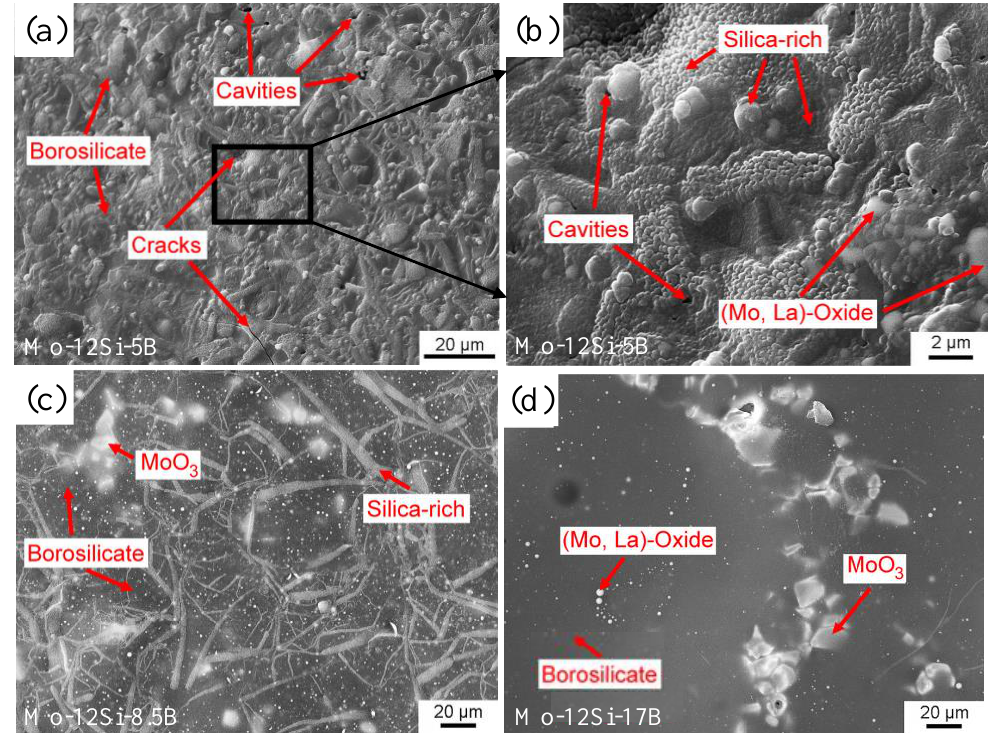
Figure 5. Surface SEM images of various alloys during oxidation 30 h at 1000 °C. ( a ) Mo-12Si-5B alloy with magnified image ( b ), ( c ) Mo-12Si-8.5B alloy, ( d ) Mo-12Si-17B alloy. Reproduced with permission [44]. Copyright 2019 Elsevier.